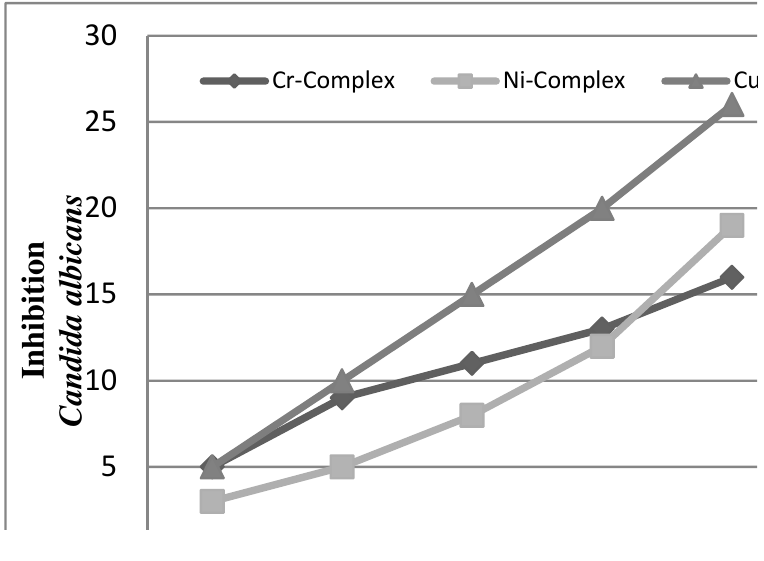
Figure 8. The effect of complexes toward Candida albicans